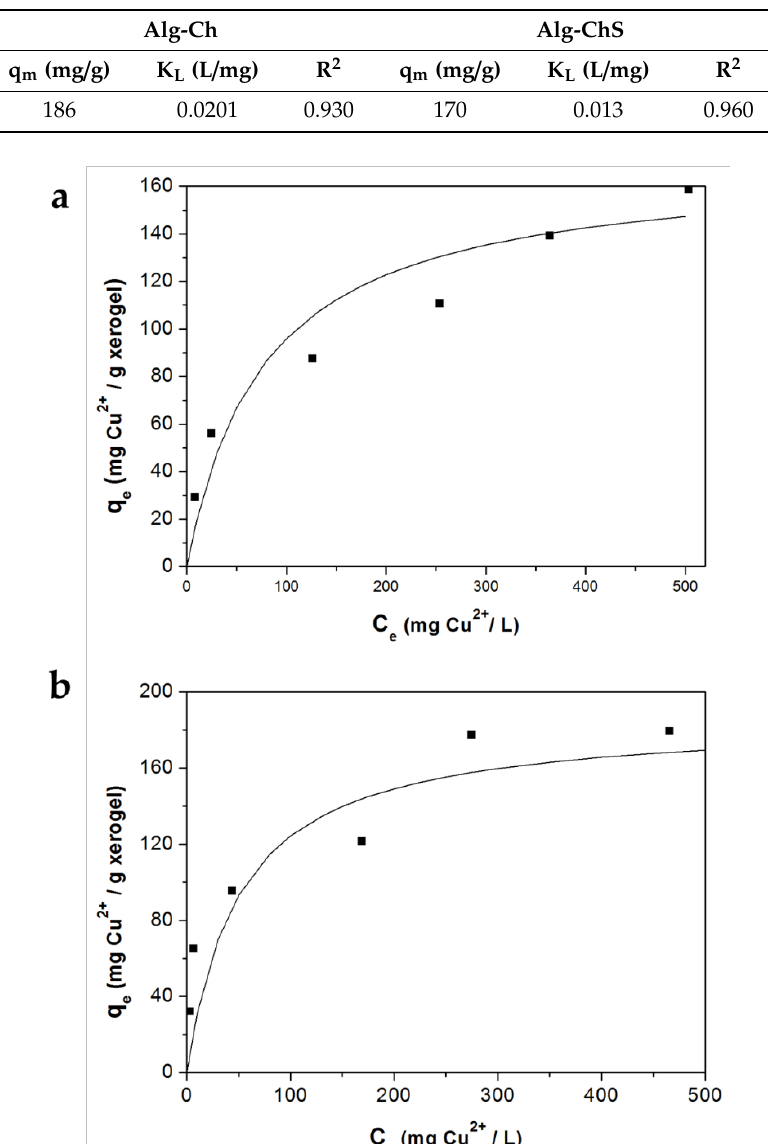
Table 2. Isotherm constants of the Langmuir model for adsorption of Cu(II).